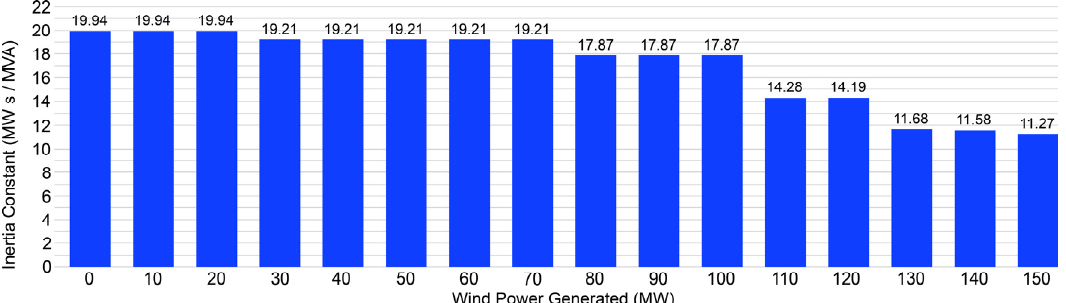
Figure 11. Power system inertia for different amounts of wind power.